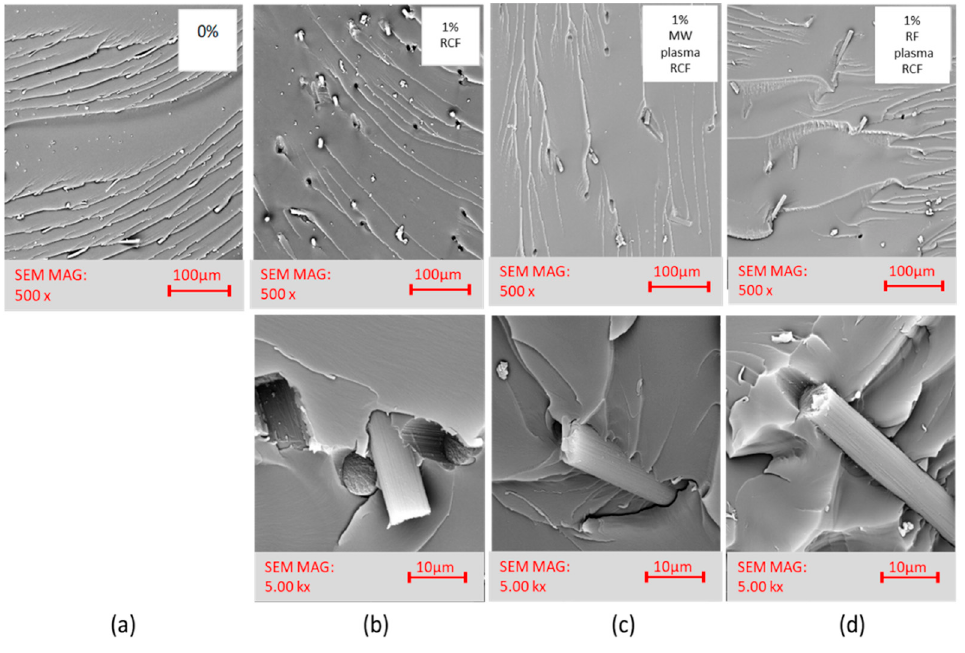
Figure 10. SEM photos of FRE after impact toughness measurements (view of the total fracture sur- face in the upper part of the figure, details of the fiber-resin interfacial interface in the lower part of the figure): ( a ) neat resin; ( b ) RCF–1 wt%; ( c ) MW plasma-treated RCF–1 wt%; and ( d ) RF plasma- treated RCF–1